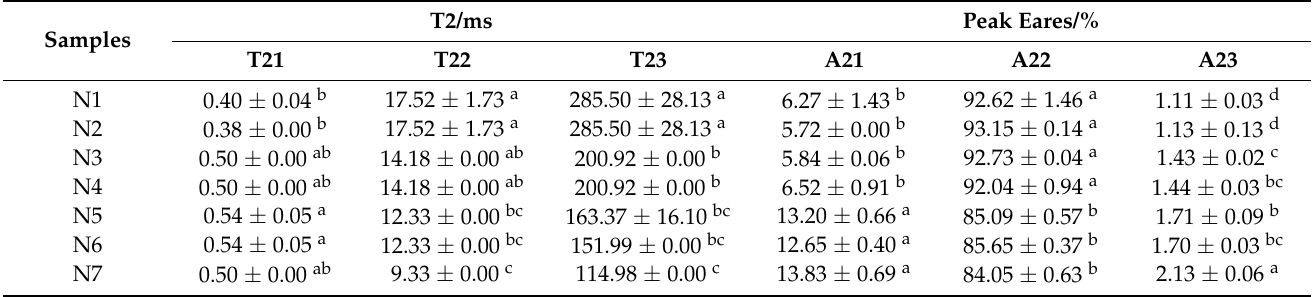
Table 2. T2 and peak areas of doughs.